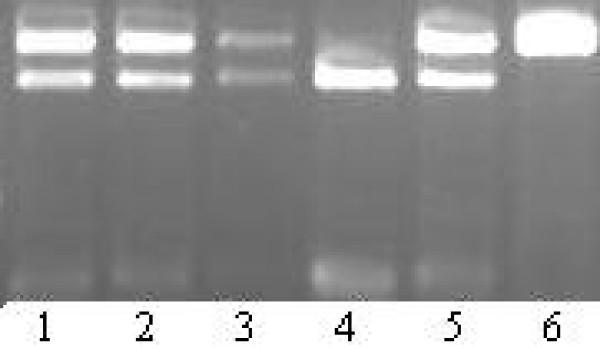
Lane 1, 2, 3 and 5 represents heterozygous Lys/Arg genotypes, lane 4 represents homozygous Lys/Lys genotypes and lane 6 represents homozygous Arg/Arg genotypes of Lys173Arg polymorphism of aldosterone synthase gene.